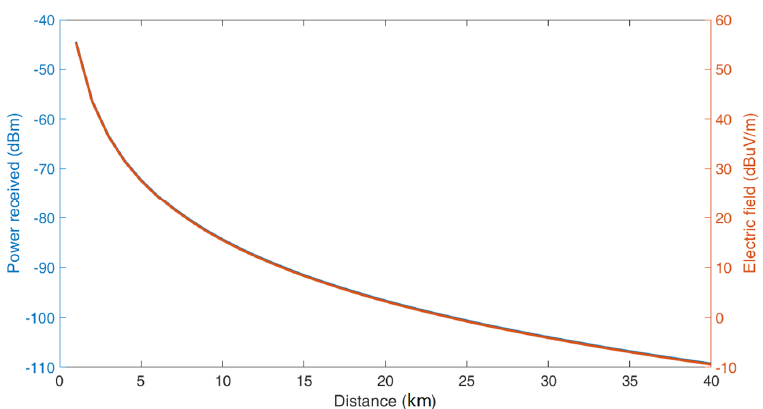
Figure 2. Received electric field and power of groundwave depending on the distance.